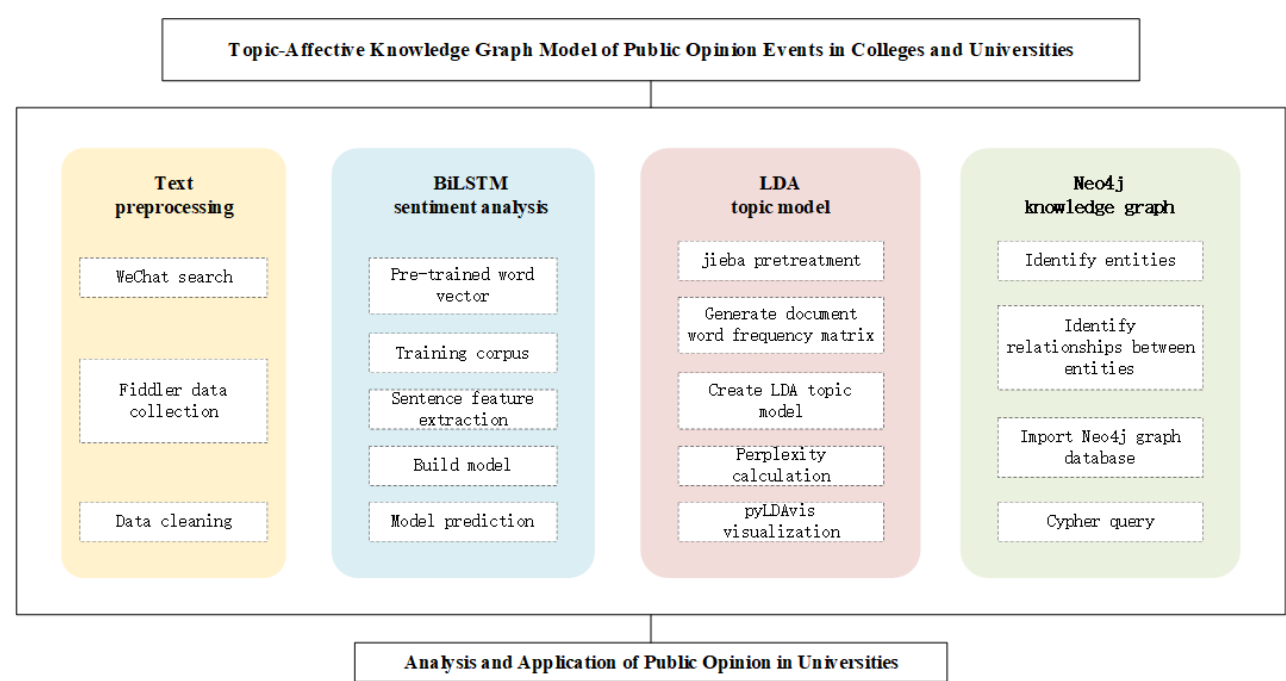
Figure 1. Topic ‐ –sentiment knowledge graph model of public opinion in colleges and universities. Figure 1. Topic—sentiment knowledge graph model of public opinion in colleges and